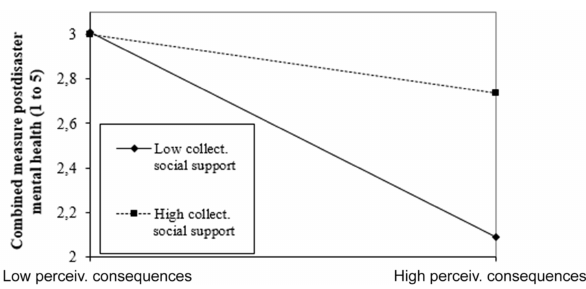
Figure 2. Combined post-disaster mental health measure (1 to 5) as a function of flood-related negative consequences and perceived collective social support.